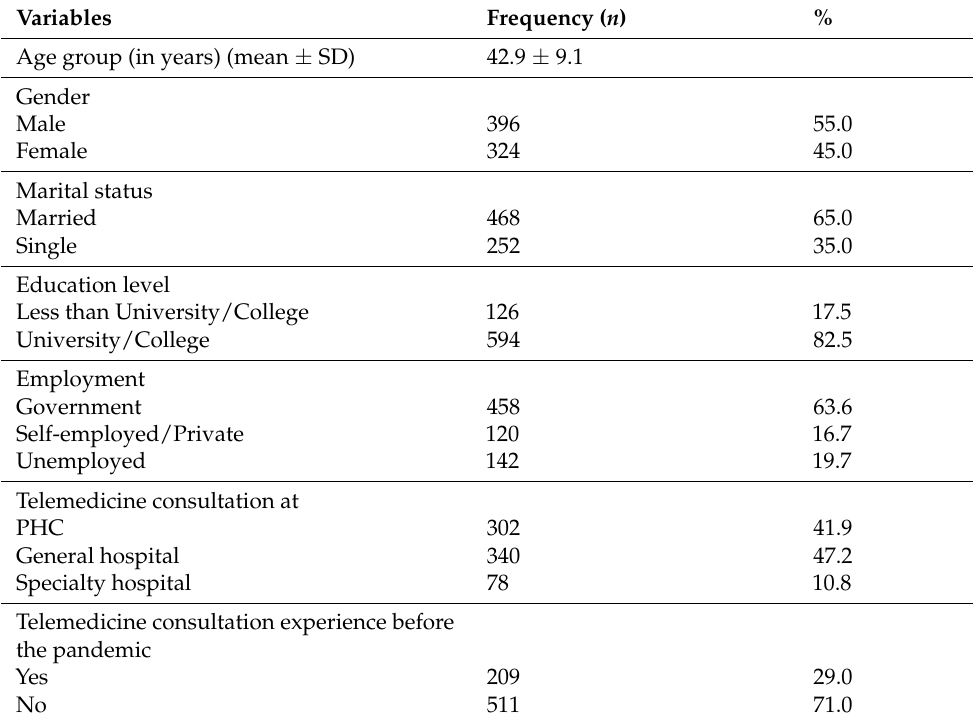
Table 1. Background details of the study participants ( n =